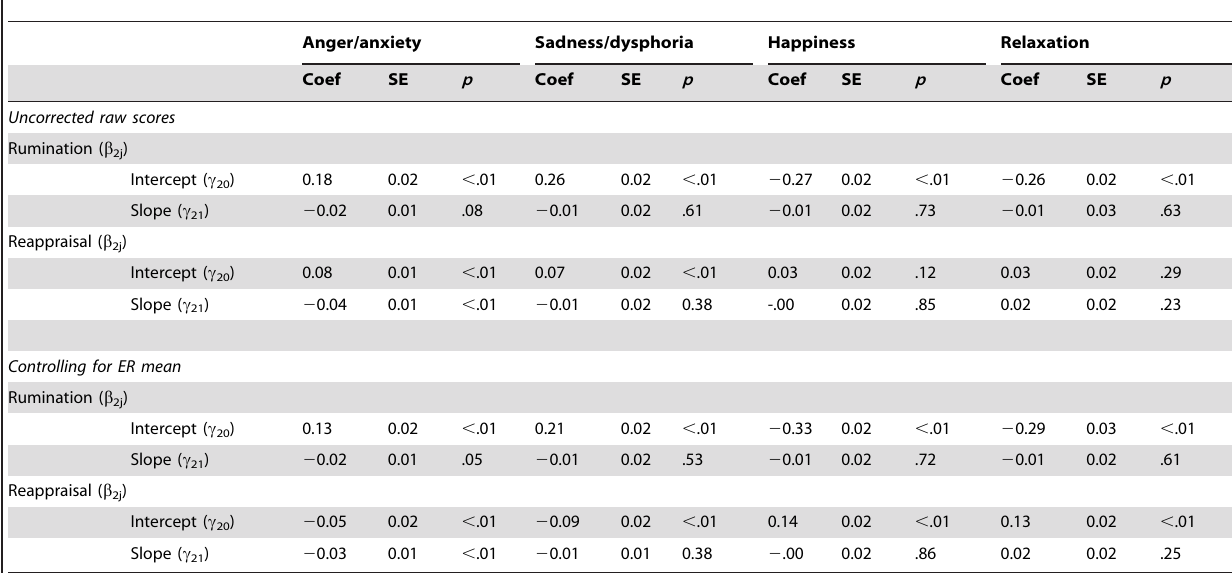
Table 4. Multilevel Analyses on the Moderating Effect of the Emotional n-back on the Relationship between Rumination/ Reappraisal and Emotions in Daily